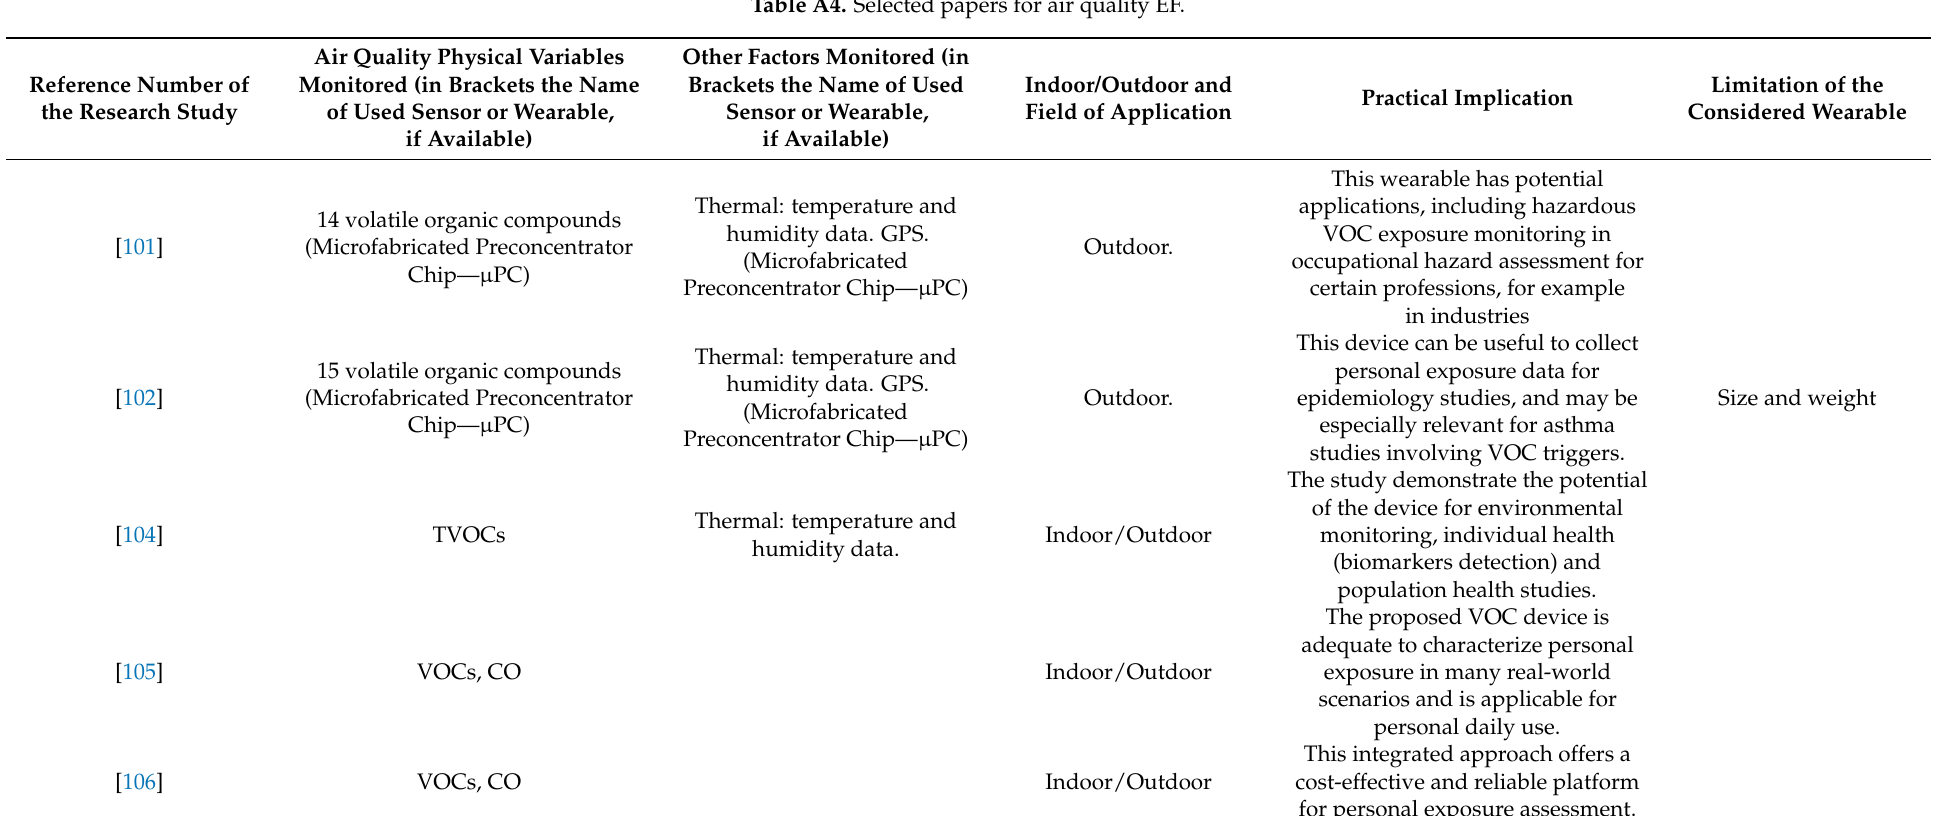
Table A4. Selected papers for air quality